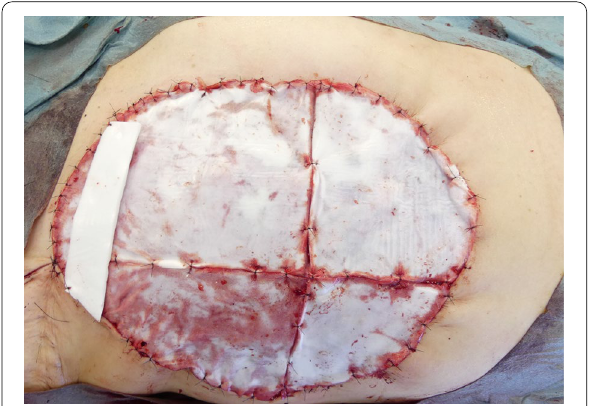
Fig. 3 Right mastectomy with axillary lymph node dissection covered with artificial skin